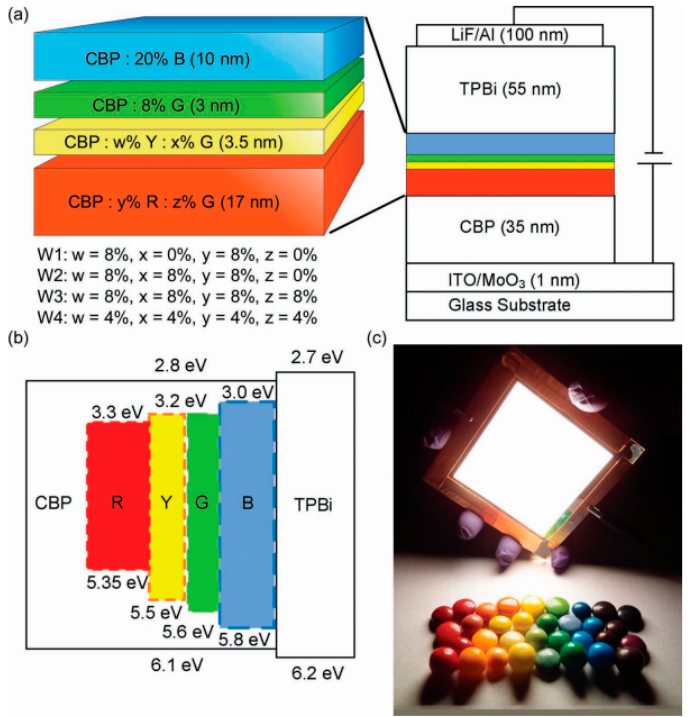
Figure 13. ( a ) The device structure. ( b ) The energy level diagrams. ( c ) A photo of a large area (80 mm × 80 mm) WOLED illuminating at 5000 cd m − 2 with a CRI of 85. Reproduced from Reference